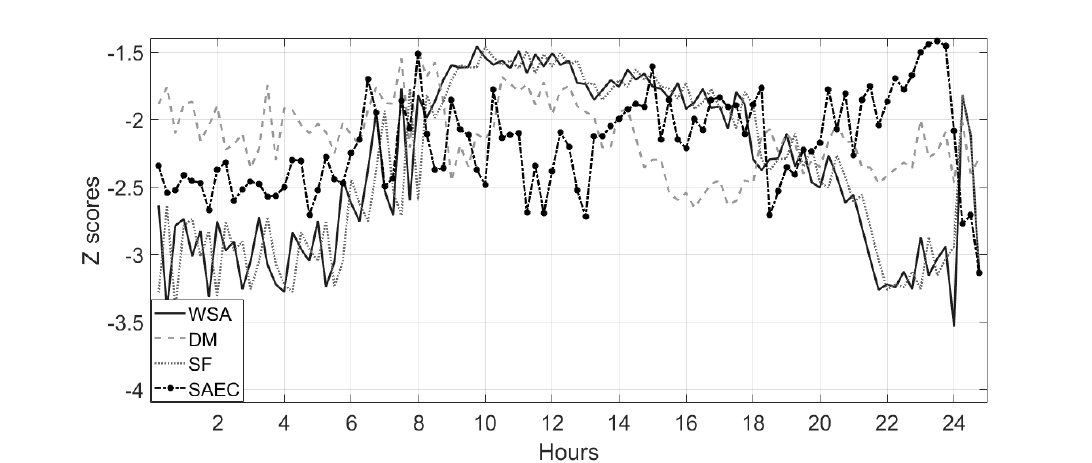
Figure 11. Minimum Z score of the consumption